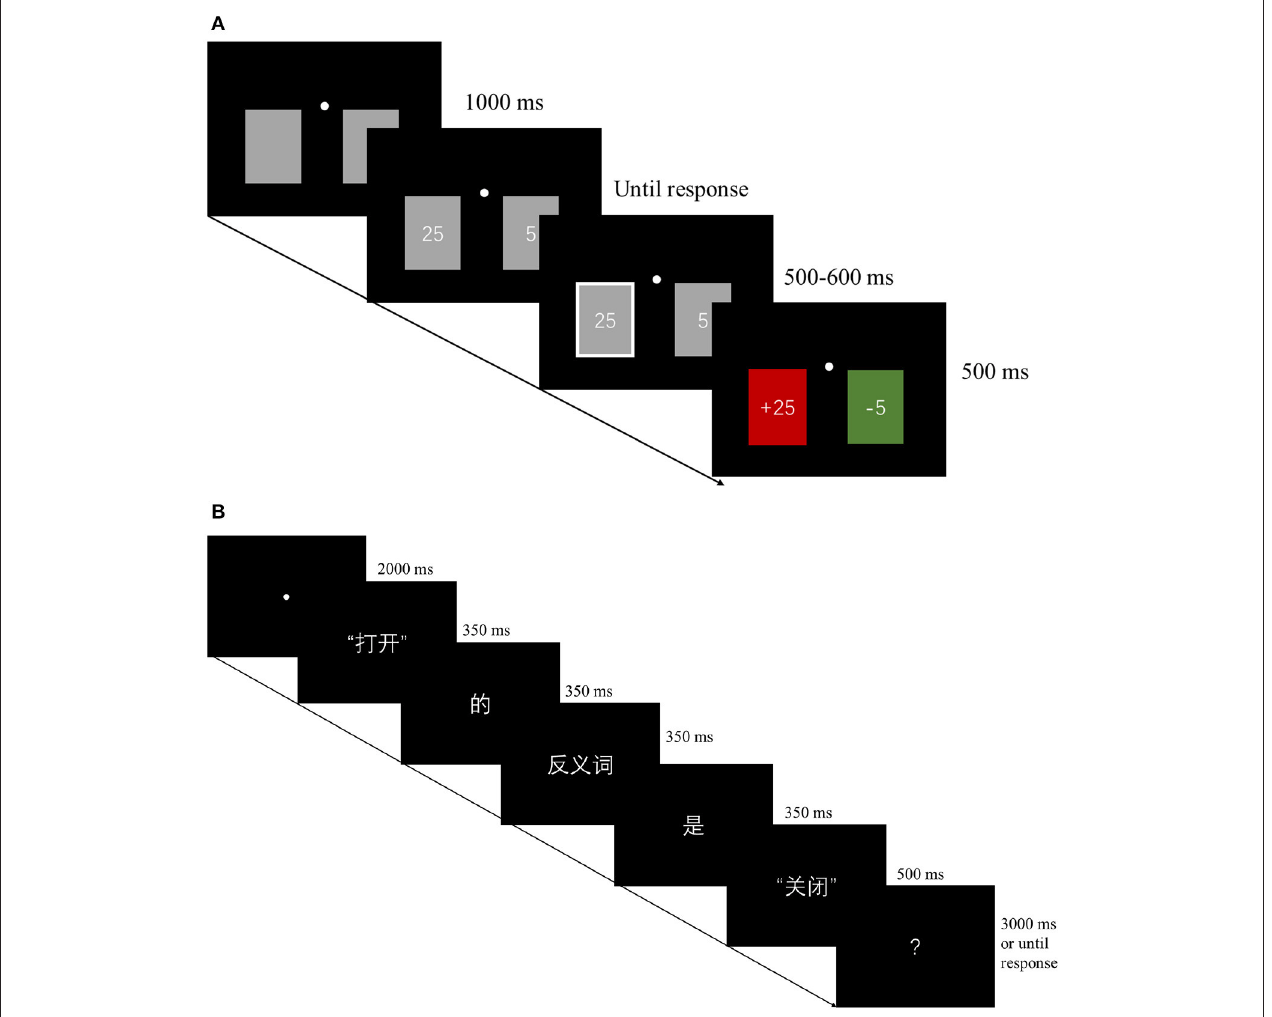
FIGURE 1 | Experimental procedures. (A) An example trial of the gambling task. The four possible number combinations (i.e., 25/25, 5/5, 5/25, and 25/5) was shown at the center of the gray cards until response. The inter-trial interval was 1,000ms. (B) An example trial of the antonym task. The illustration shows “The opposite of open is close ” in Chinese (word-by-word translation: “ 打 开 (open) / 的 (of)/ 反 义 词 (opposite)/ 是 (is)/ 关 闭 (close) ”). The ISI between each word was 200ms, except that the ISI between the word is and the critical stimuli (Y) was 200–300ms with a 50-ms per jitter step. After a 750ms ISI (range: 500–1,000ms), a question mark (?) was shown until a response was given or 3s had elapsed. The inter-trial interval was 2,250ms.